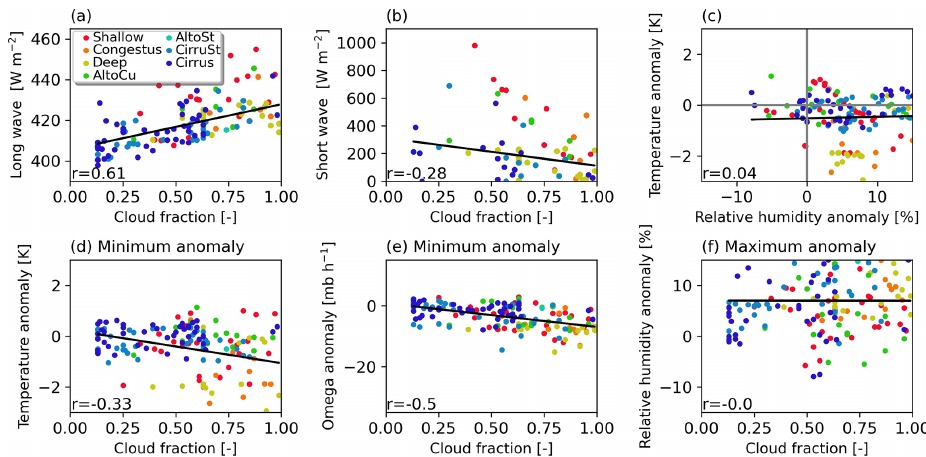
Figure 8. Scatter plot between observed cloud fraction and longwave radiation, shortwave radiation, precipitation rate, minimum values of temperature variance, minimum omega, and maximum relative humidity for selected cases during IOP2 (dry season). Each color represents a cloud type: blue (cirrus), cobalt (cirrost), teal (altost), green (altocu), yellow (deep), orange (congestus), red (shallow) and white (clear